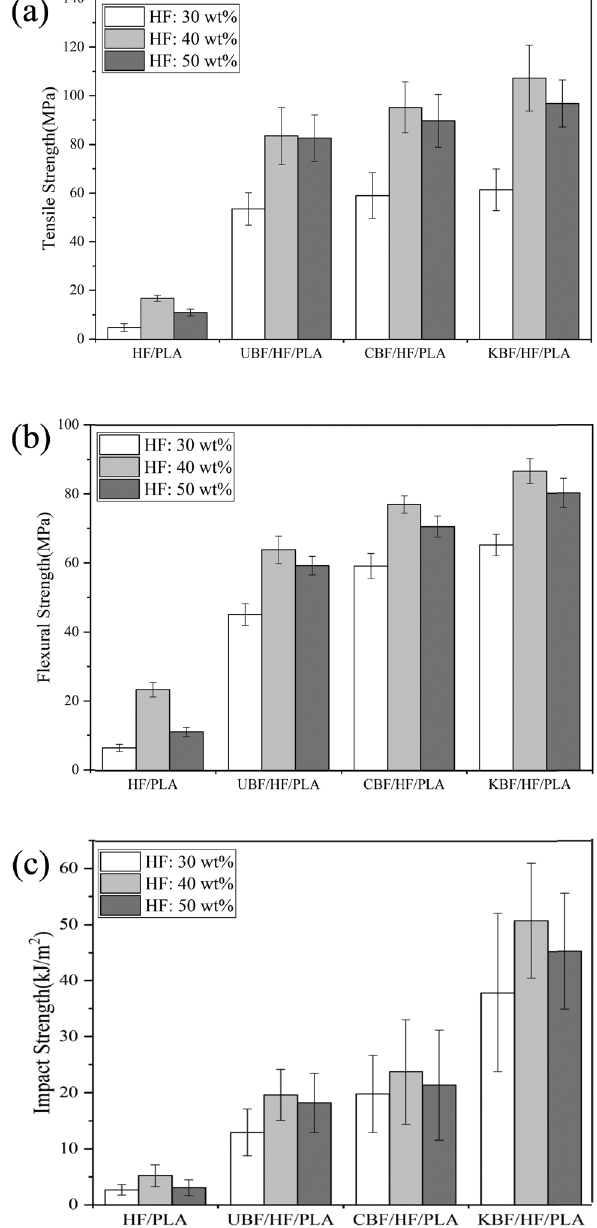
Figure 10: Mechanical properties of composites: ( a ) tensile strength, ( b ) fl exural strength, and ( c ) and impact